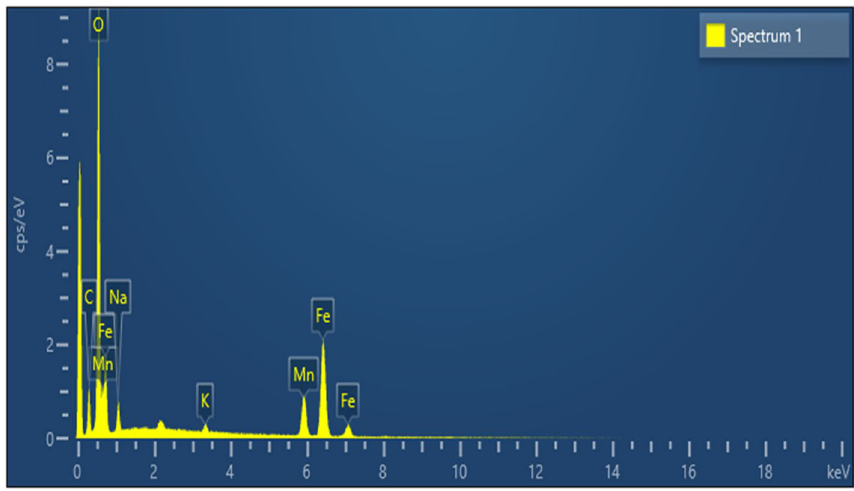
Figure 2. EDX surface analysis of sample S4.